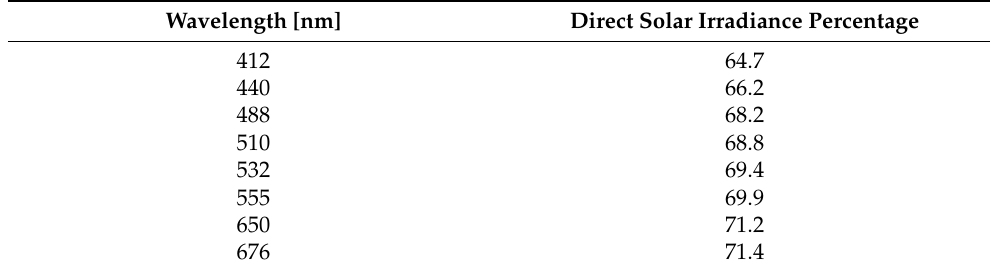
Table 5. The direct solar irradiance contributions used in the sea environment optical model [28]. Wavelength [nm]